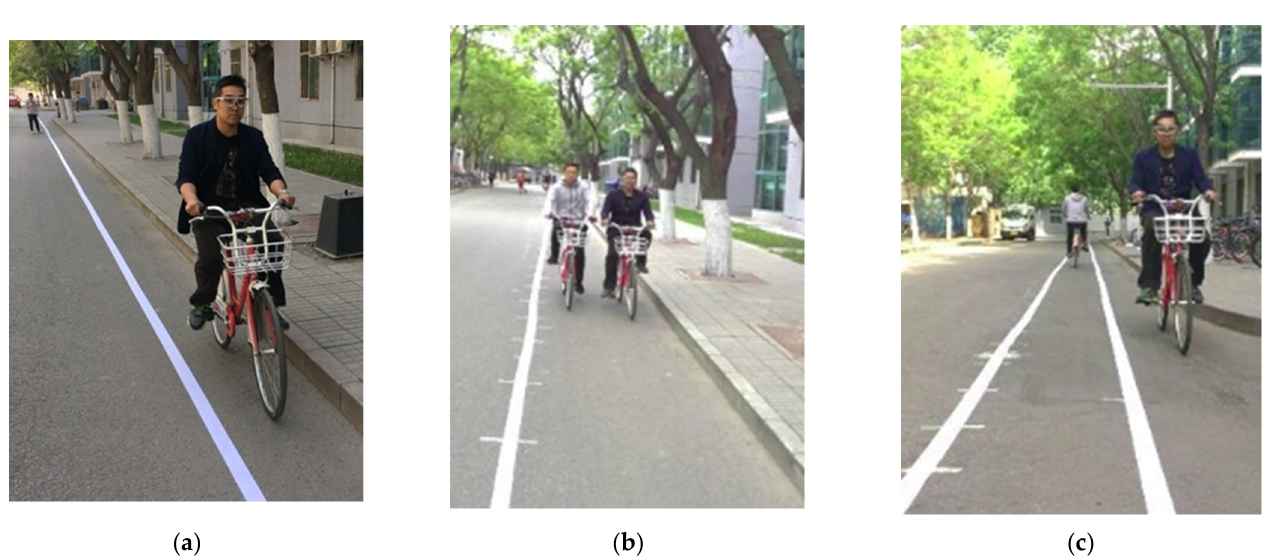
+ barrier scenario. ( b ) curb